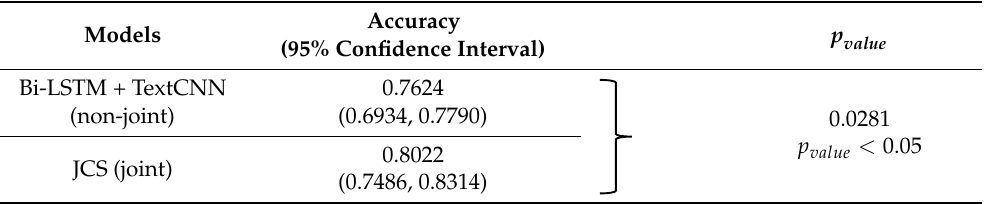
Table 5. Statistical analysis of the two models.